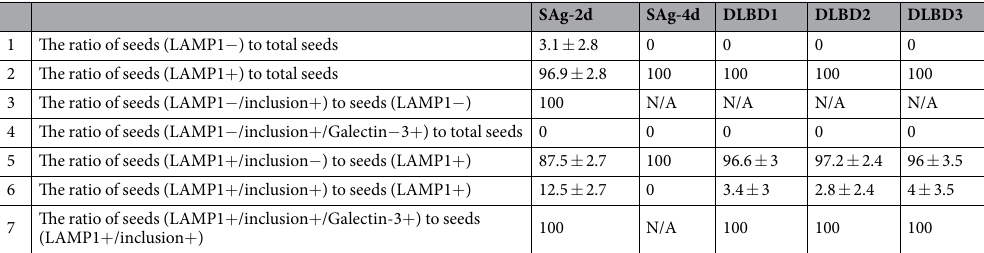
Table 1. Quantification of the seeds associated with different structures in different groups in Fig. 4. Note: All values are Pathological α S aggregates isolated from brains with Lewy body pathology preferentially show endocytosis-mediated seeding. To determine if the seeding activity and pathway of α S aggregates formed from recombinant protein in vitro and isolated form human brain are comparable, α S was immuno- precipitated from the amygdala of 3 patients with DLBD (referred to as DLBD1, DLBD2 and DLBD3) and one age-matched control. The concentration of α S in each sample was determined using ELISA (KHB0061, Thermo Fisher Scientific). The same amount (0.1 µ g) of α S or control sample was added into H4/V1S-SV2 cells for 2 days; then, the number of cells containing seeded α S inclusions from each group was counted and compared.